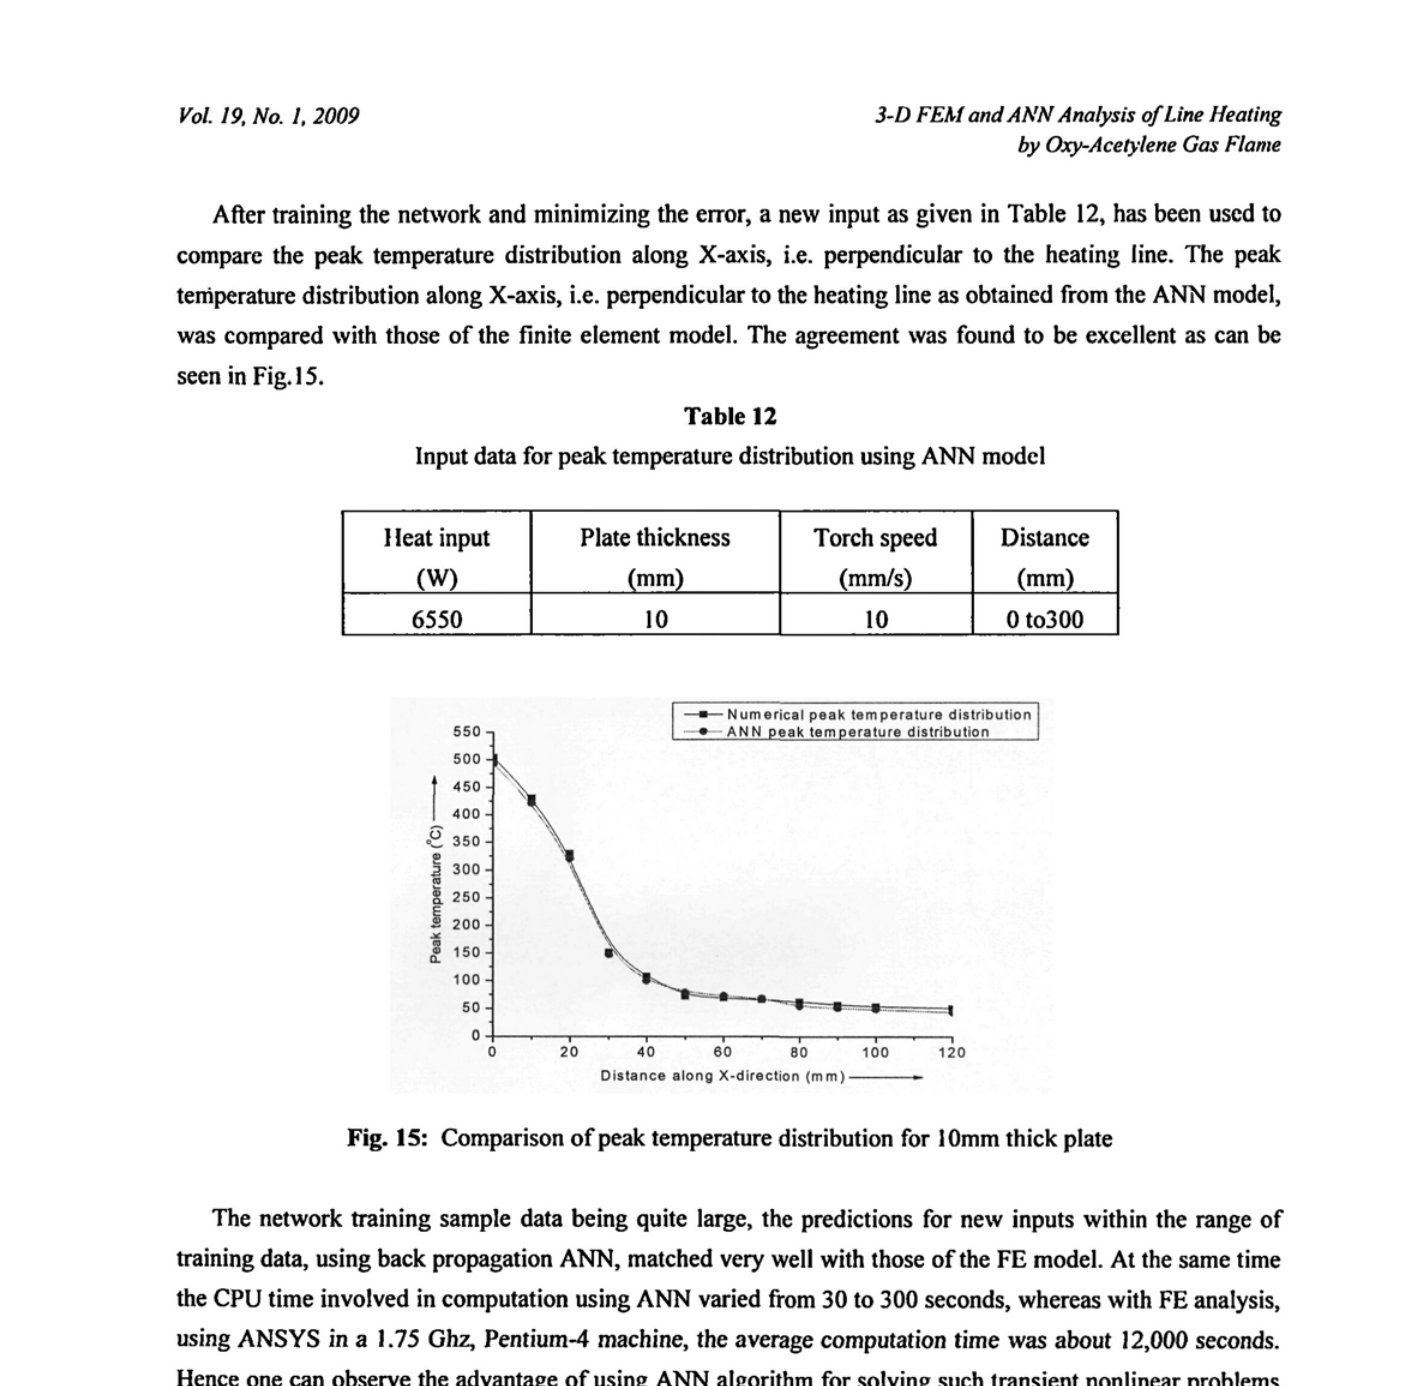
Input data for peak temperature distribution using ANN model